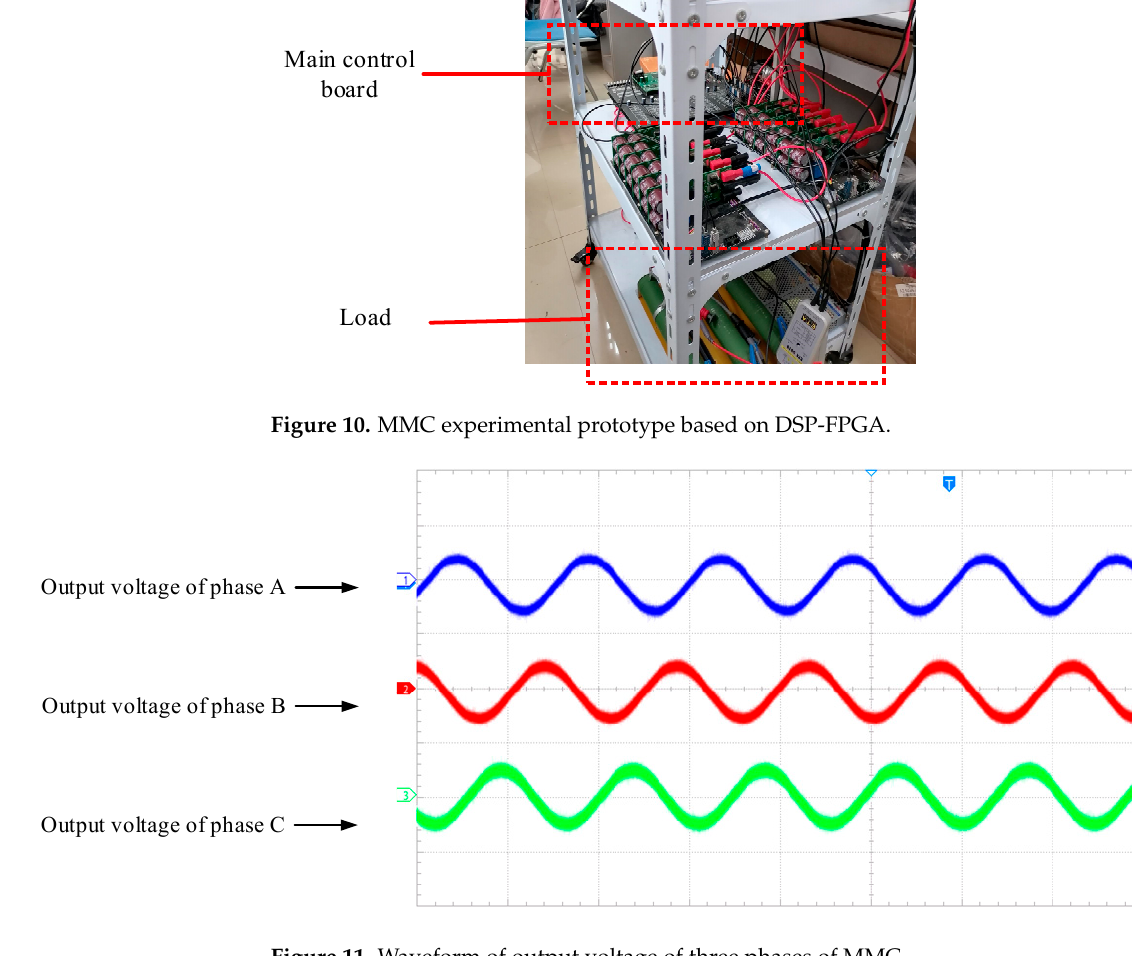
Figure 11. Waveform of output voltage of three phases of MMC.